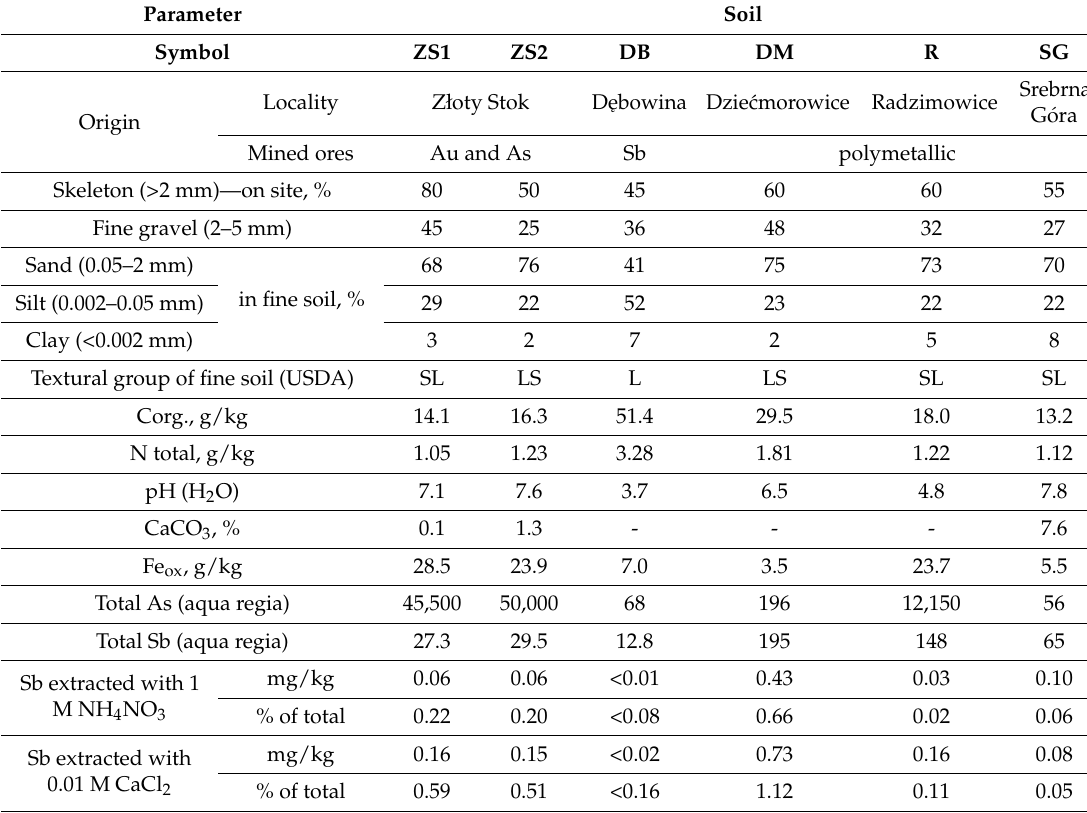
Table 1. Soil origin and basic properties used in the experiment (the mean values of three replicates). Chemical properties determined in fine soil (<2